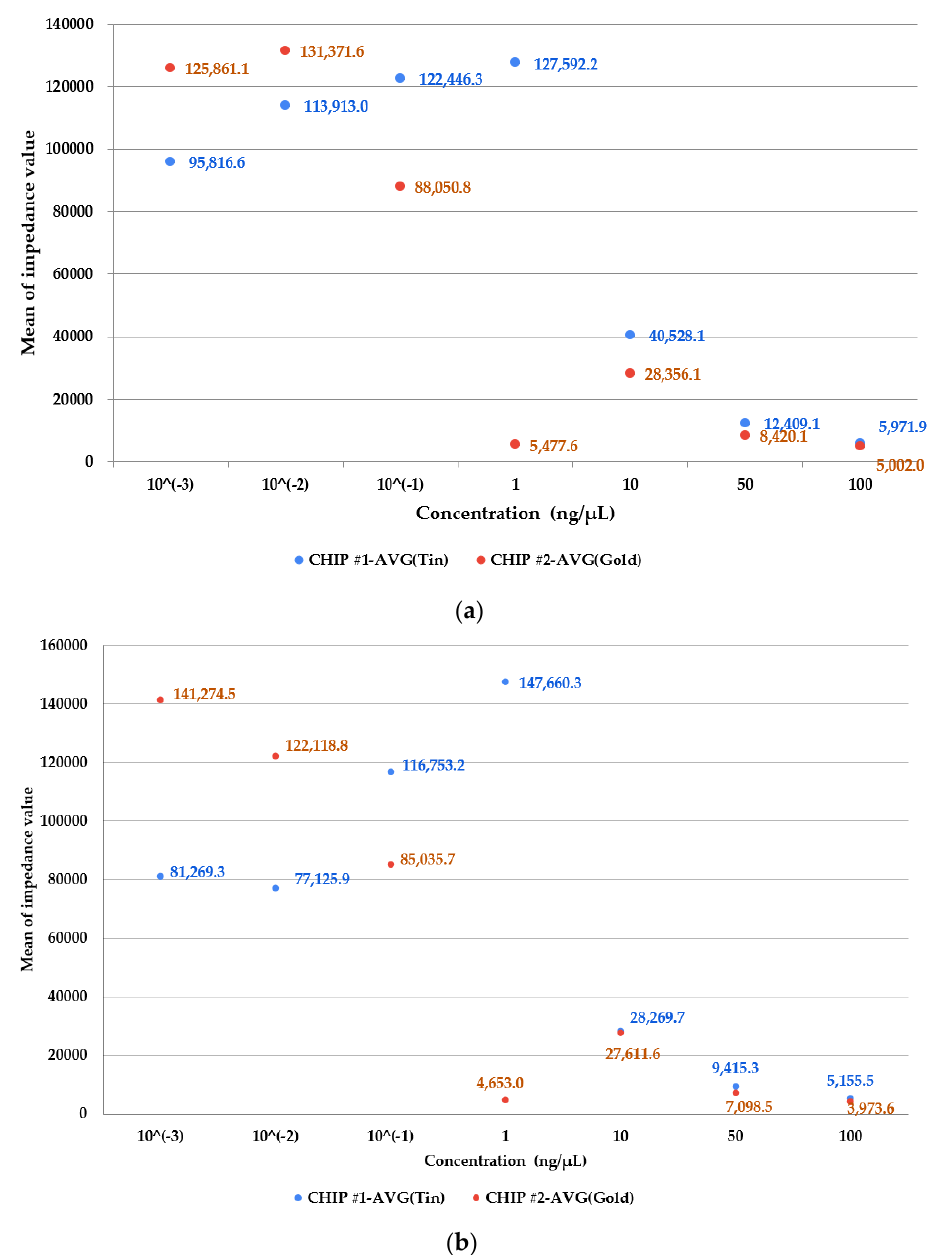
Figure 6. Change of average impedance by sample concentration in two types of chips according to the input resistance. ( a ) Input resistance: 39 Ω ( b ) Input resistance: 62 Ω .